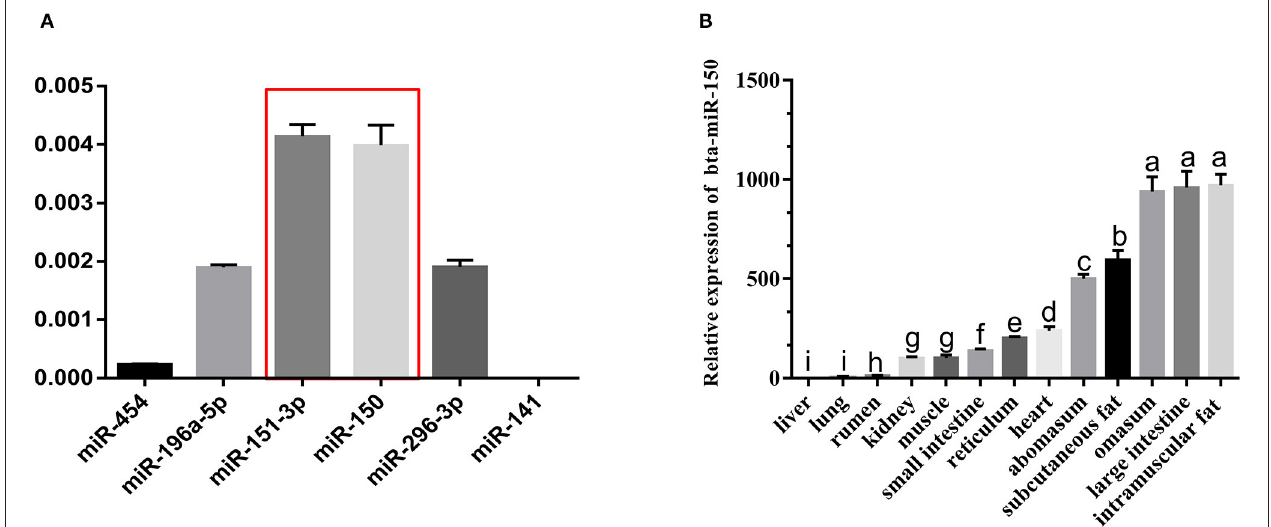
FIGURE 1 | miR-150 is expressed at high levels in bovine adipocytes. (A) Background expression of miR-150. (B) Tissue expression profile of miR-150. Values with superscript letters indicate mean significant difference ( p <